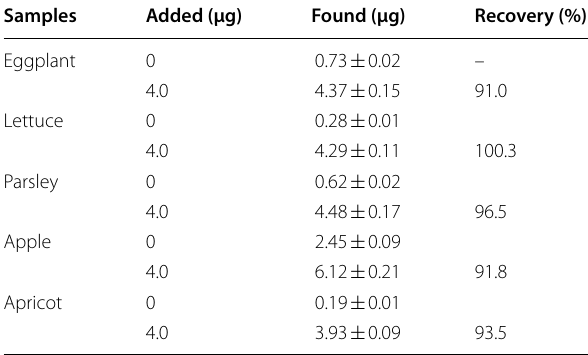
Table 8 Addition/recovery data for solid samples (vegetable and fruit quantities: 0.750 g)